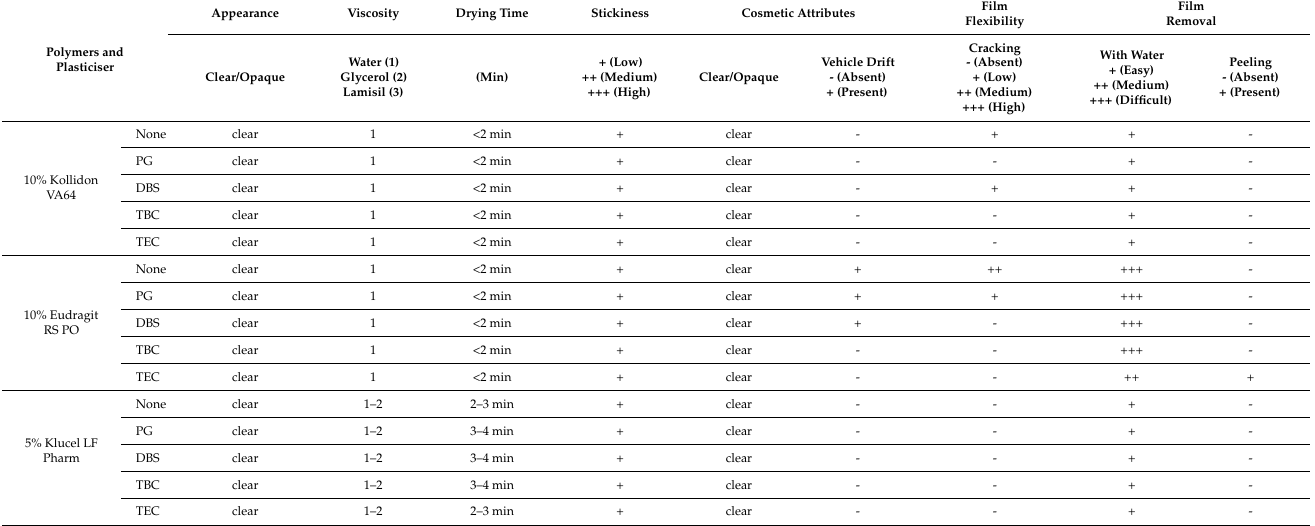
Table 2. Visual evaluation of film-forming systems containing different types of